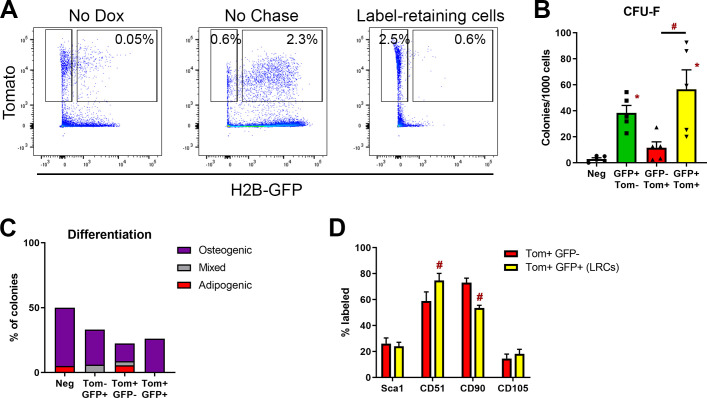
Alpha smooth muscle actin (αSMA)-labeled periosteal label-retaining cells are enriched with colony-forming unit fibroblast (CFU-F).(A) Representative flow plots showing identification of αSMA-labeled label-retaining cells. Values represent an average of n = 3–10. (B) CFU-F formation and (C) differentiation of colonies under mixed osteogenic/adipogenic conditions of αSMA-labeled label-retaining cells and other subpopulations (n = 5 for CFU-F, n = 3 for differentiation). (D) Cell surface marker expression in αSMA-labeled subpopulations. *p<0.05 compared to negative population, #p<0.05 compared to Tom+GFP- population.